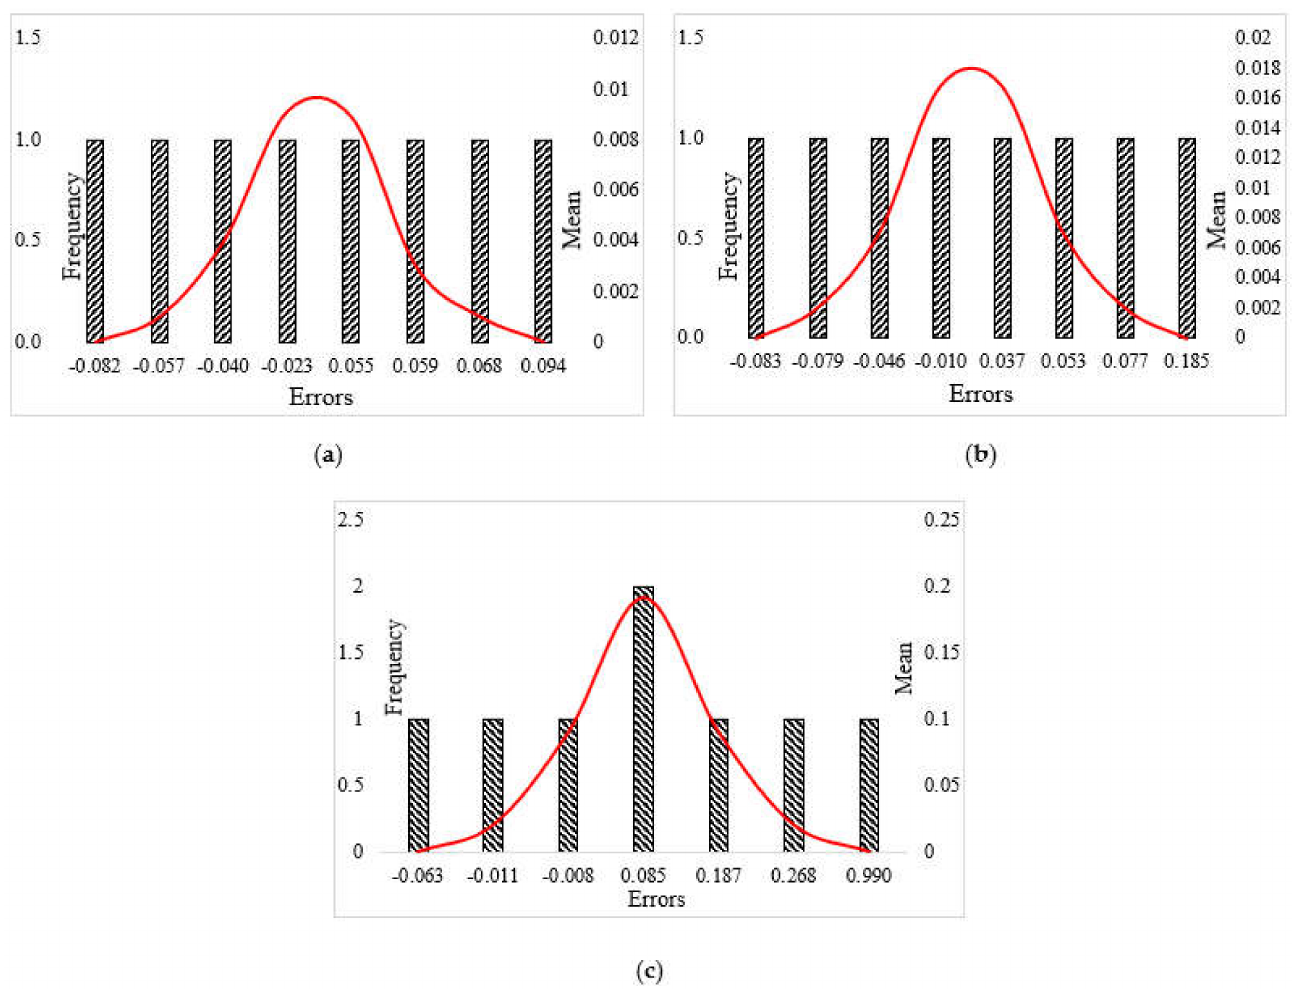
Figure 18. Error histograms for: ( a ) ANFIS-PSO, ( b ) ANFIS-ACO and ( c ) ANFIS-DEO